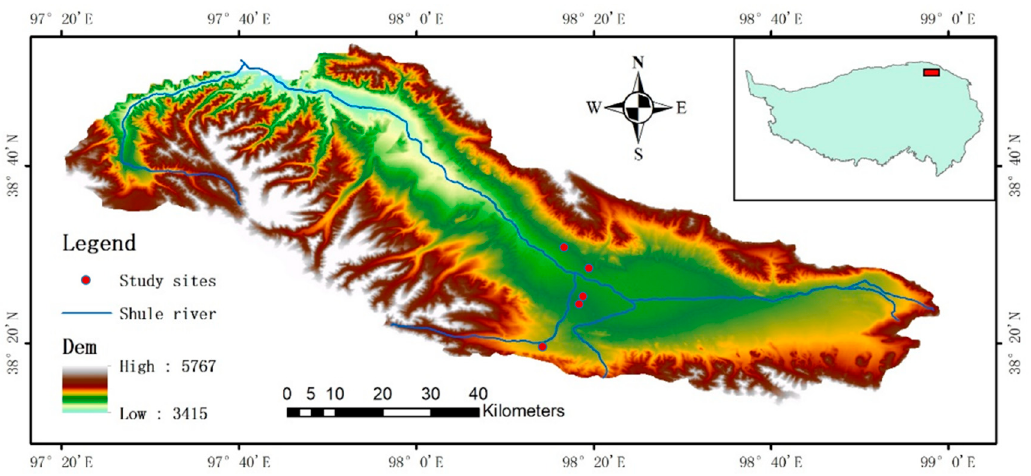
Figure 1. Spatial distribution of study sites in the upper reaches of Shule River.